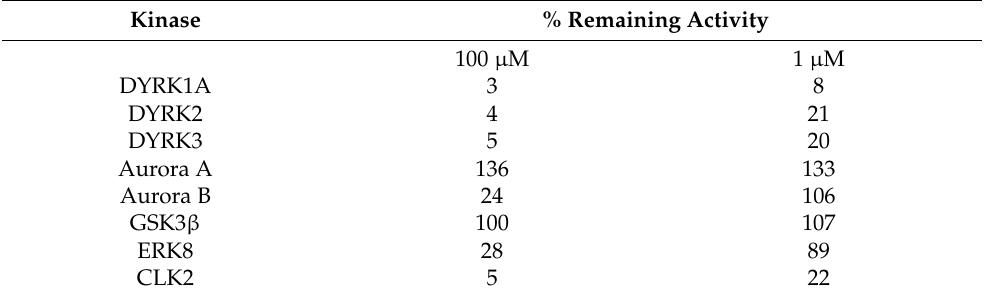
Table 1. Percent remaining inhibitory activity at high and low PST-001 concentration on a panel of protein kinases. The full profile data set is compiled in the Supplementary Information (Table S2). Kinase % Remaining Kinase